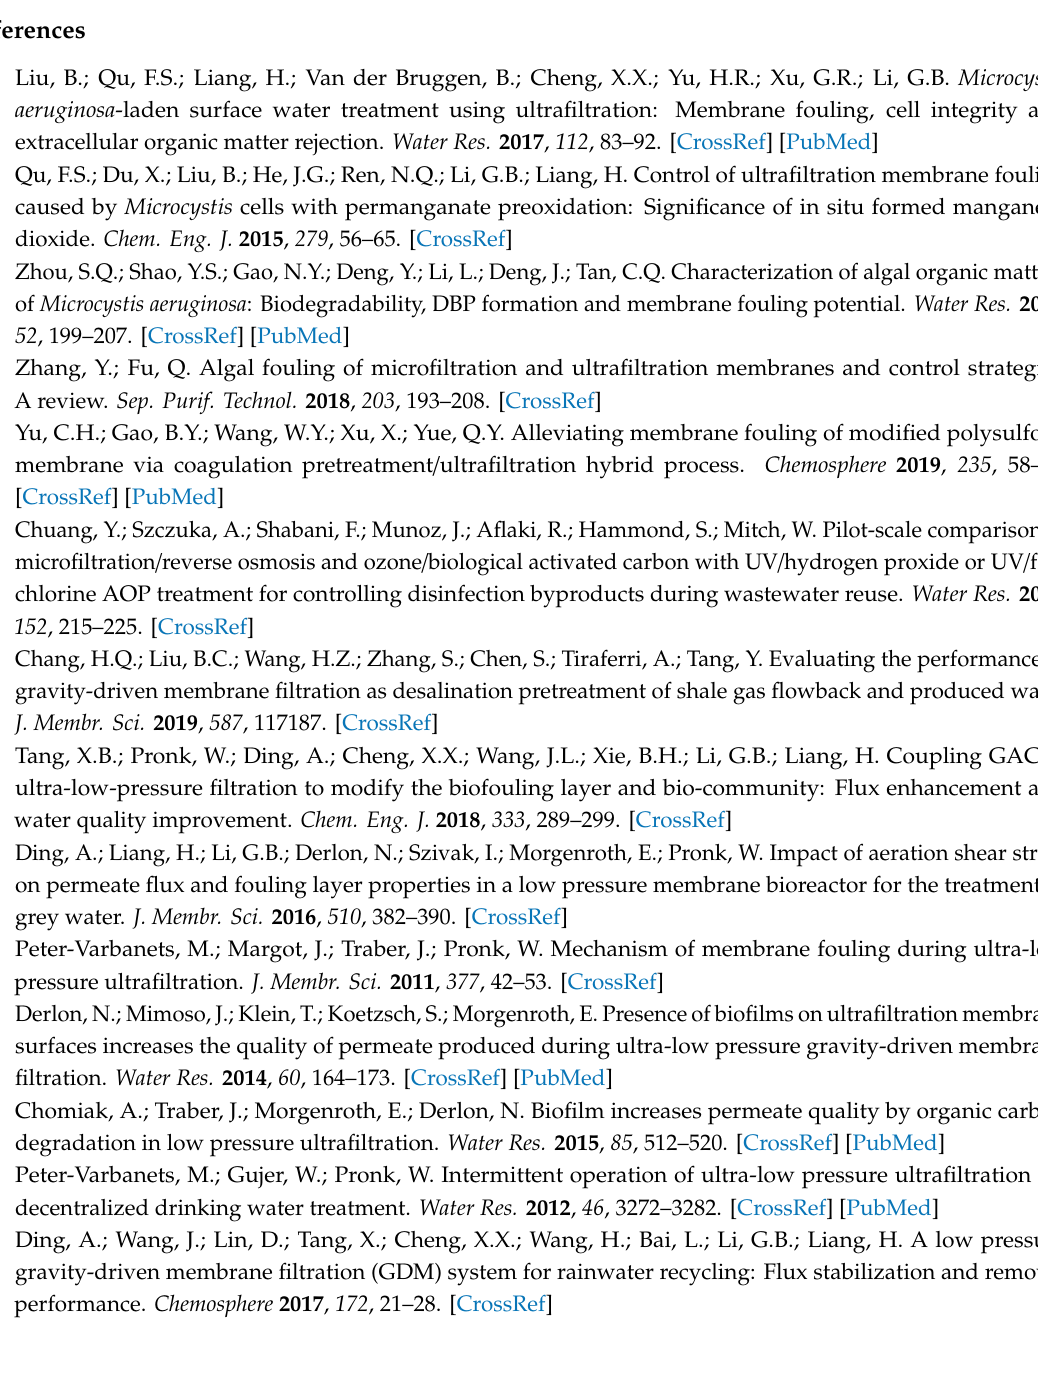
Figure S4. (a) Algae density and (b) UV 254 of di ff erent steps at three periods of the experiment. Figure S5. DOC removal e ffi ciency of di ff erent MWs of suspensions in AS and AS-CS coagulation treatment at the 27th day of the experiment. Figure S6. (a) Zeta potential, (b) pH and (c) NH 3 -N of di ff erent steps at the 27th day of the experiment. Table S1. Equations of di ff erent fouling models for dead-end